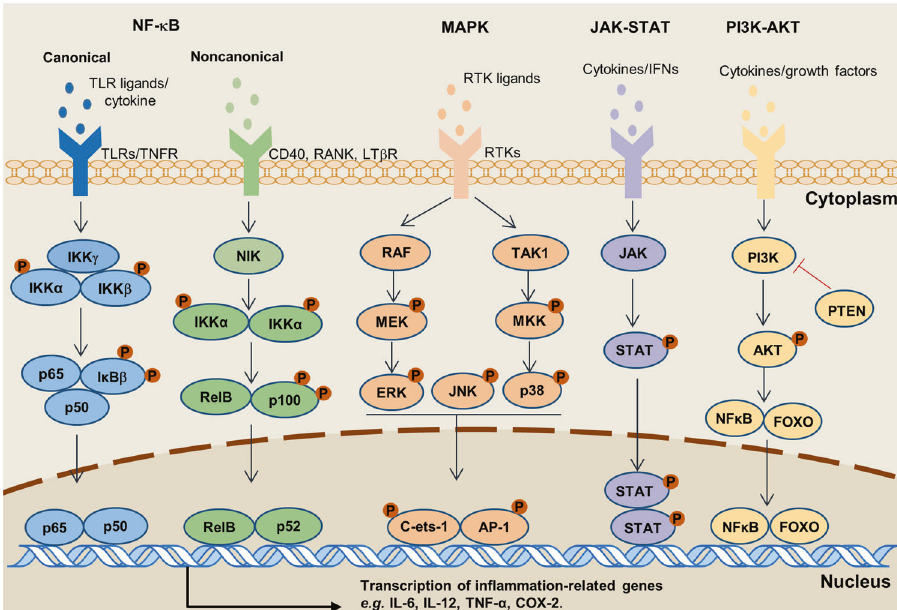
Fig. 2 In fl ammatory signaling pathways involved in cancer development. Intracellular signaling pathways involved in in fl ammation and tumor development are activated via distinct receptors at the cell membrane. Subsequent downstream signaling events activate several well- characterized pathways: NF- κ B, MAPK, JAK-STAT, and PI3K-AKT. These pathways regulate various in fl ammatory factors